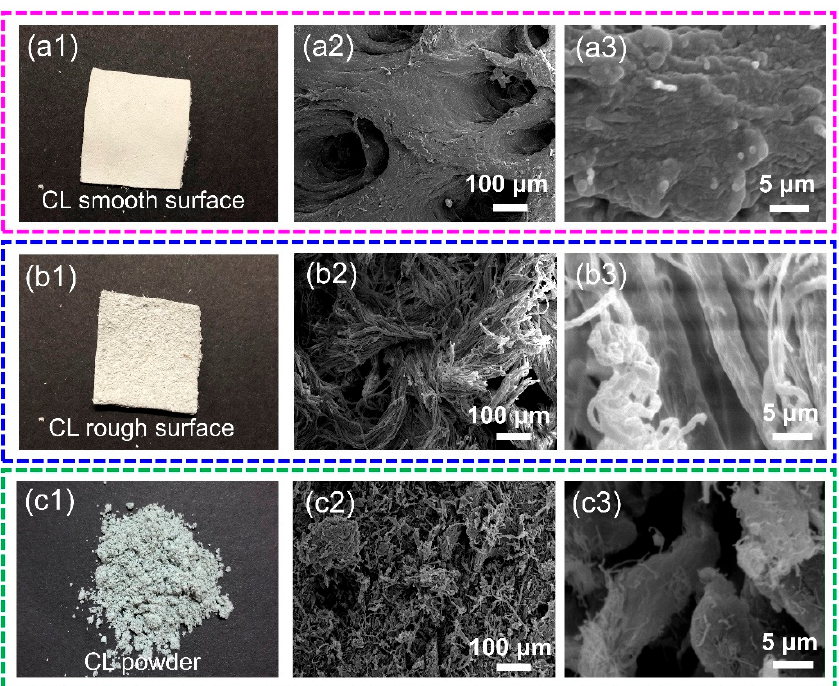
Figure 3. ( a1 – a3 ) Photographs and SEM images for the smooth surface of CL; ( b1 – b3 ) photographs and SEM images for the rough surface of CL; ( c1 – c3 ) photographs and SEM images of CL powders. The measurement of particle sizes varies in complexity depending on the shape of the